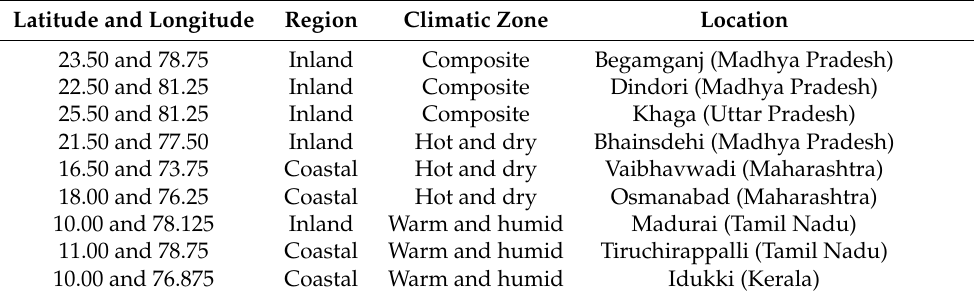
Table 2. Dataset description.